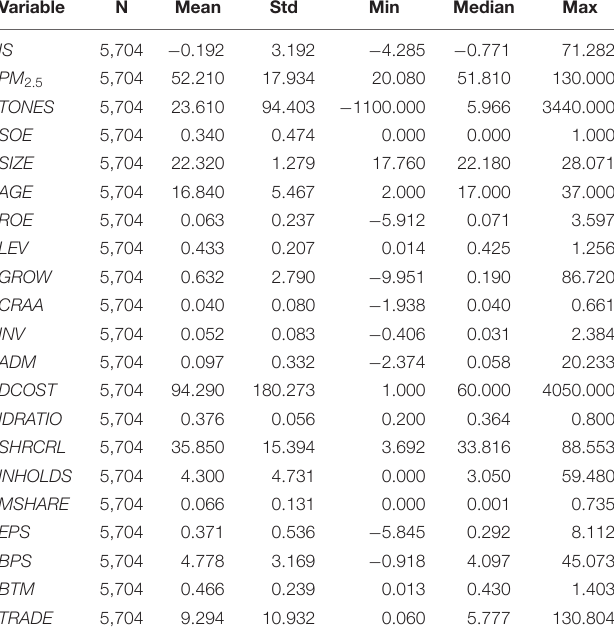
TABLE 2 | Descriptive statistics. TABLE 3 | The impact of PM2.5 on investor sentiment and moderating effect of media